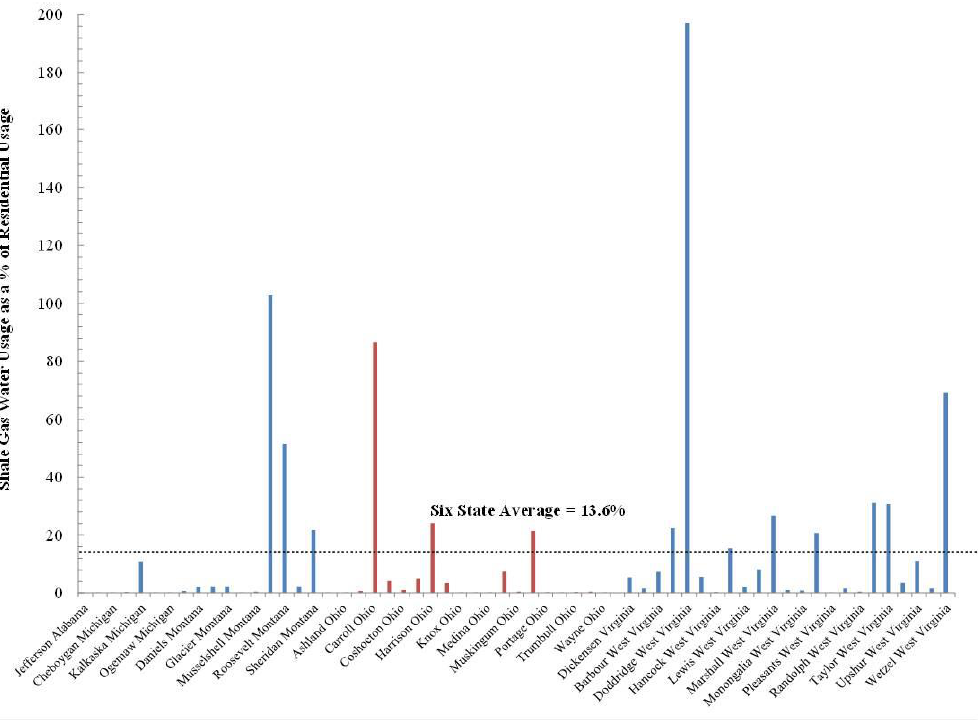
Figure 7. Hydraulic fracturing water demand across six states as a percent of annual residential water demand.